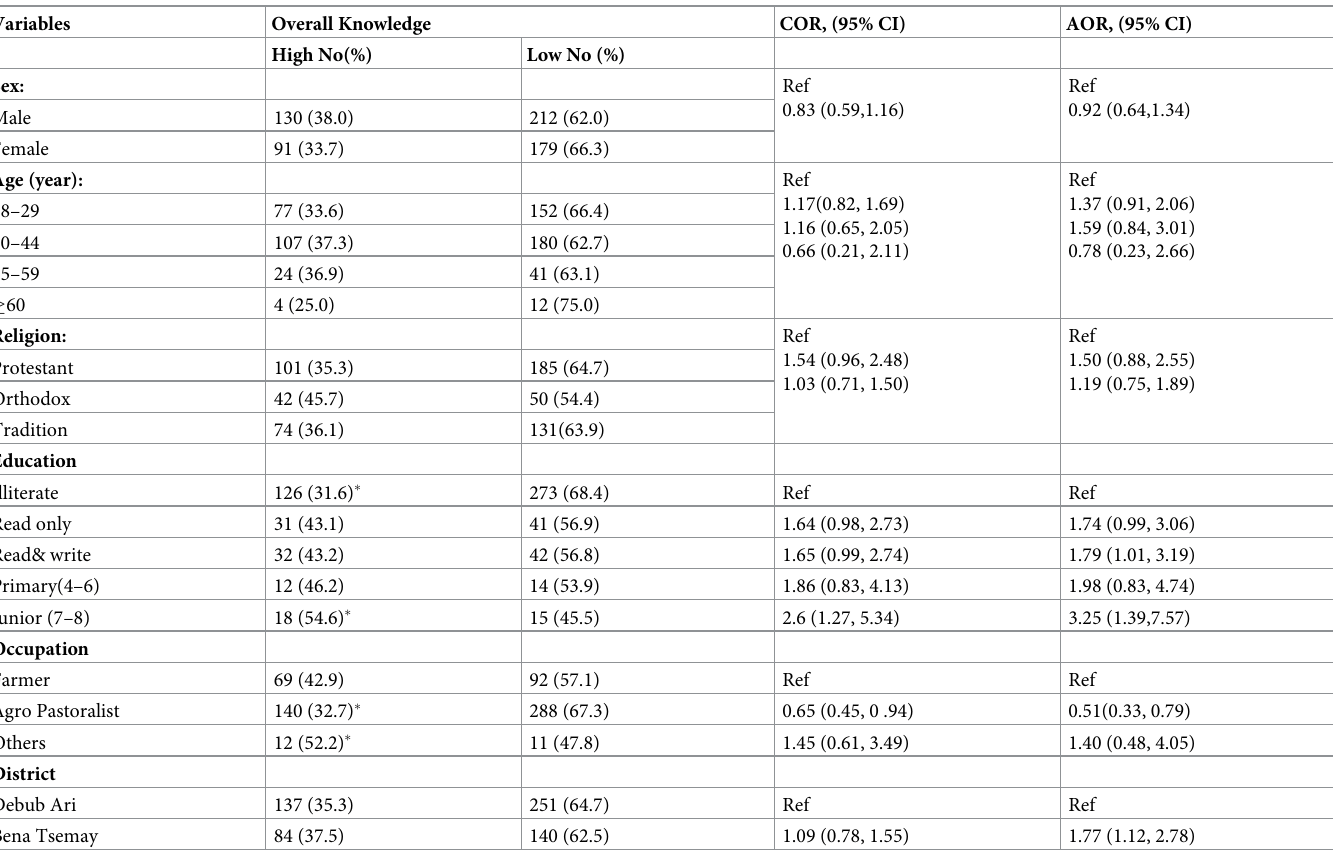
Table 6. Association of socio-demographic characteristics of the study participants with overall knowledge of